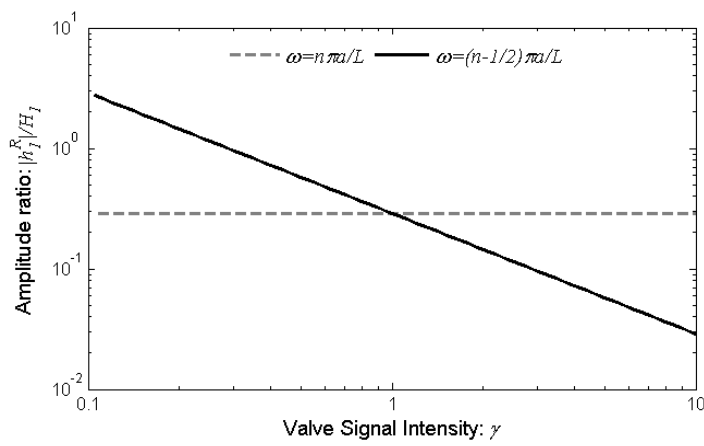
Figure 3. Impact of the VSI conditions on the resonances and anti-resonances of the upstream pressure fluctuation.